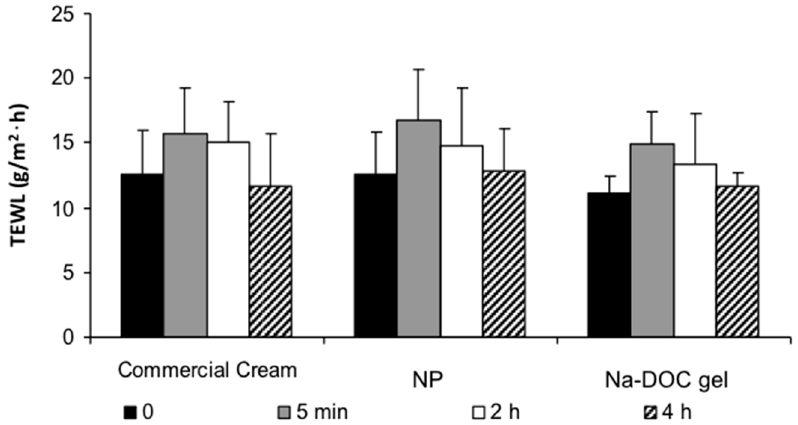
Figure 3. Transepidermal water loss (TEWL) values recorded before formulation application and 5 min, 2 and 4 h after its removal. The effect on TEWL of Dermovate (commercial cream), of the CP-loaded nanoparticles formulation (NP) and of a sodium deoxycholate gel (Na-DOC gel) were compared. All products were applied for 1 h.